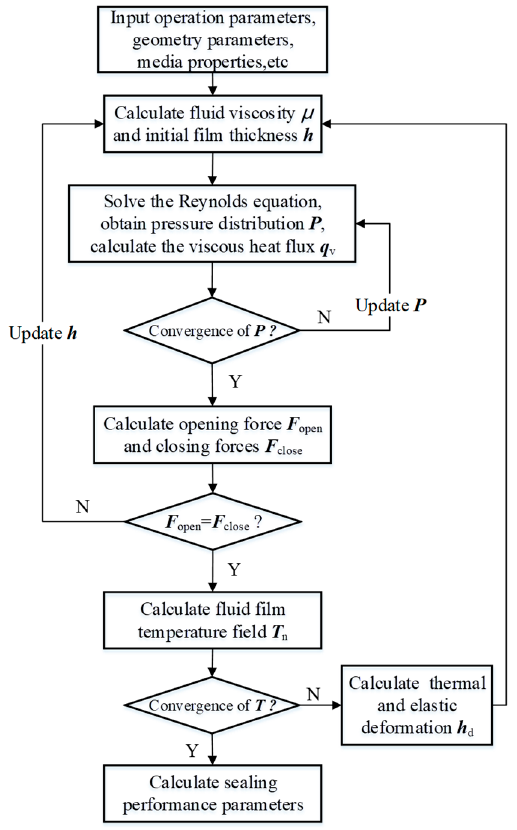
Figure 3. Computational procedure.